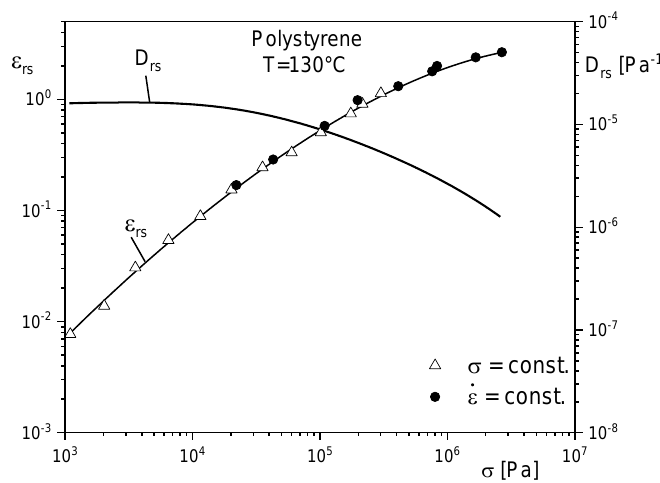
s = const. e = const.